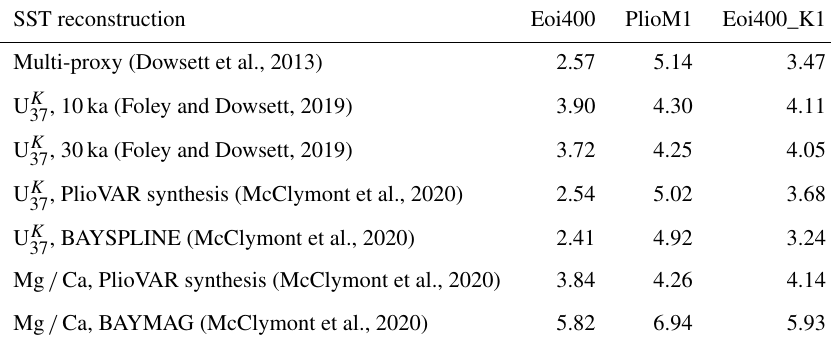
Table 2. Root mean square deviation between North Atlantic sea surface temperatures of selected mid-Pliocene simulations (Eoi400, PlioM1, and Eoi400_K1) and available